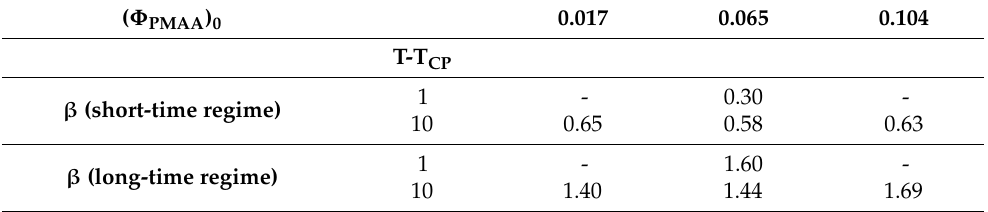
Table 3. Exponents β of the power laws describing the time evolution of S / V ( S / V α t β ) occurring during the LCST phase separation of PMAA solutions at different concentrations. The transition is monitored following a temperature jump from 25 °C up to T CP + 1 °C and T CP + 10 °C).